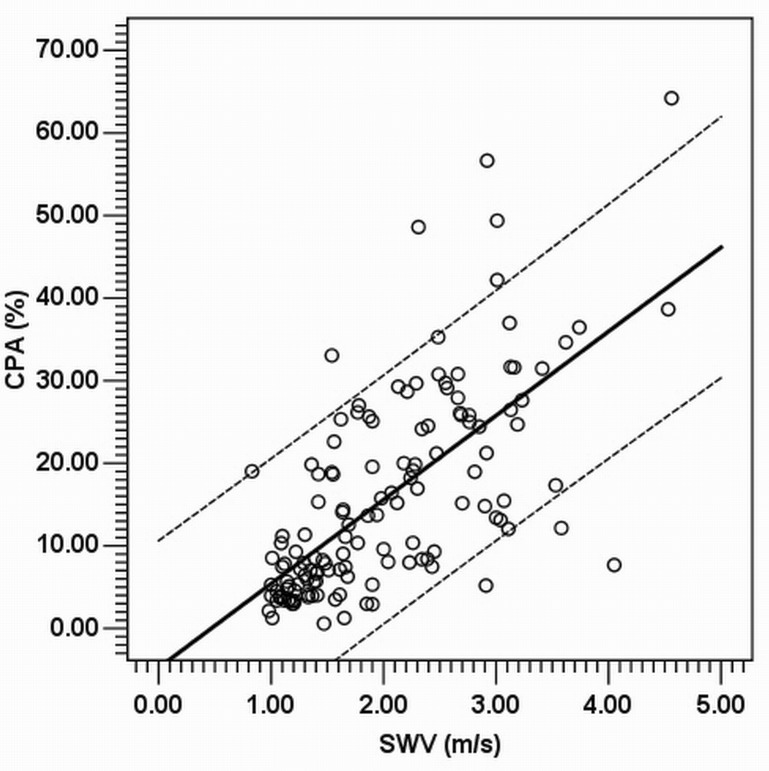
Scatter plot between the CPAa (Y-axis) and SWVb (X-axis).For CPA prediction by using SWV through univariate linear regression, the CPA (%) = -4.768 + SWV (m/s) × 10.184, as a line of best fit (R2 = 0.455, P < 0.001). Eight of 137 cases (5.8%) exceeded the 95% confidence intervals. acollagen proportionate area; bshear wave velocity.